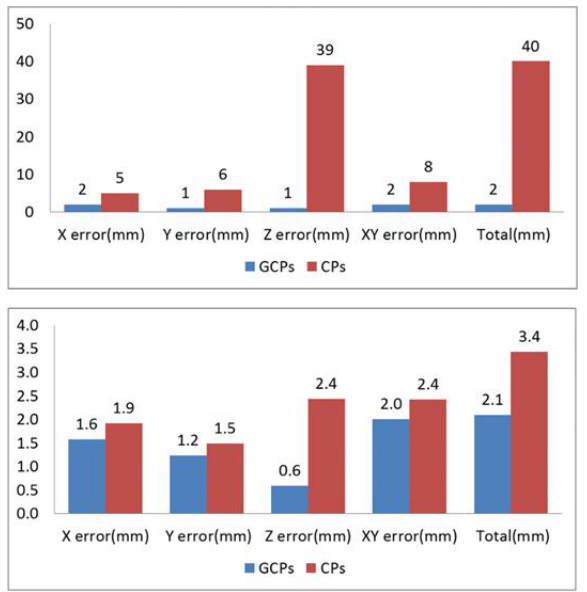
Fig. 8: RMSE values at GCPs and CPs for configurations K1 (top) and K2 (bottom) during simultaneous calibration. Note the different scaling.